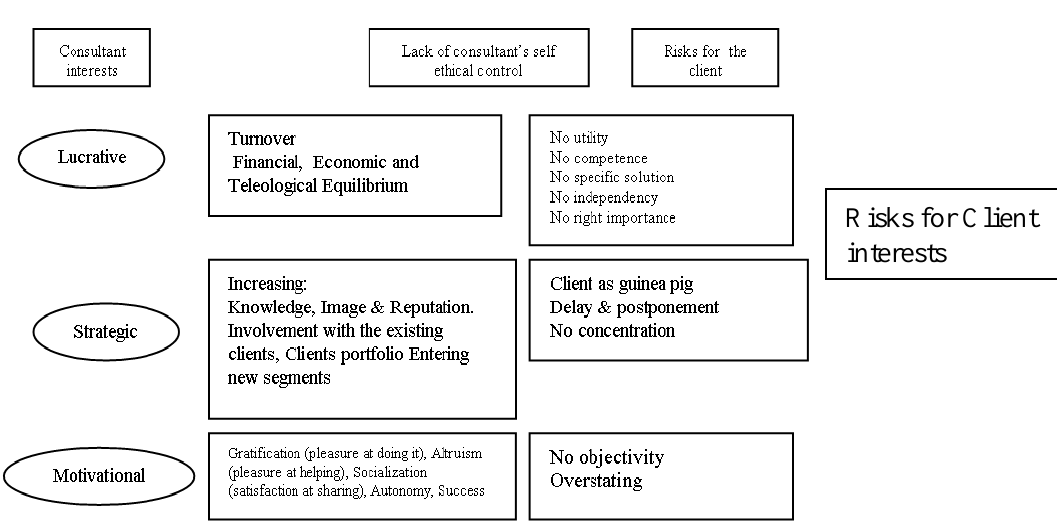
Figure 3 : Typical Risks from the Lack of Consultant’s Self-Ethical Control